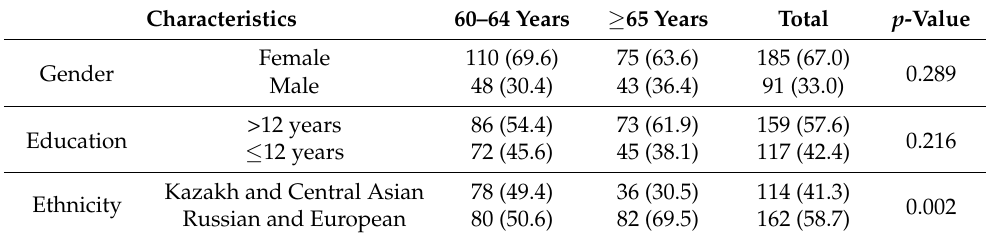
Table 1. Demographic characteristics of study participants.